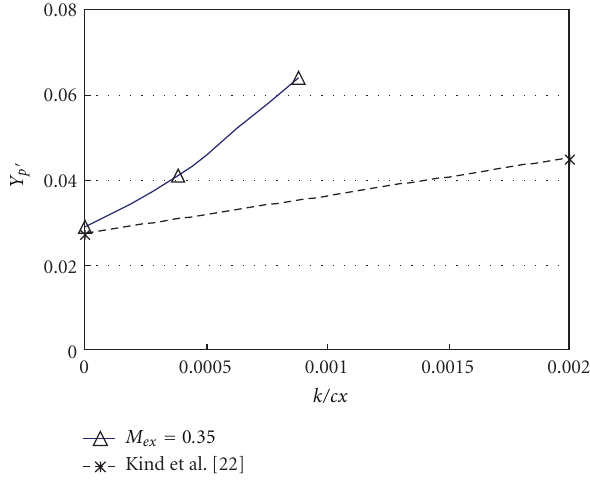
Figure 22: Comparison of mass-averaged loss coe ffi cients with similar results from Kind et al. [22], for a cambered vane with Tu = 1.1–1.6 percent [38].